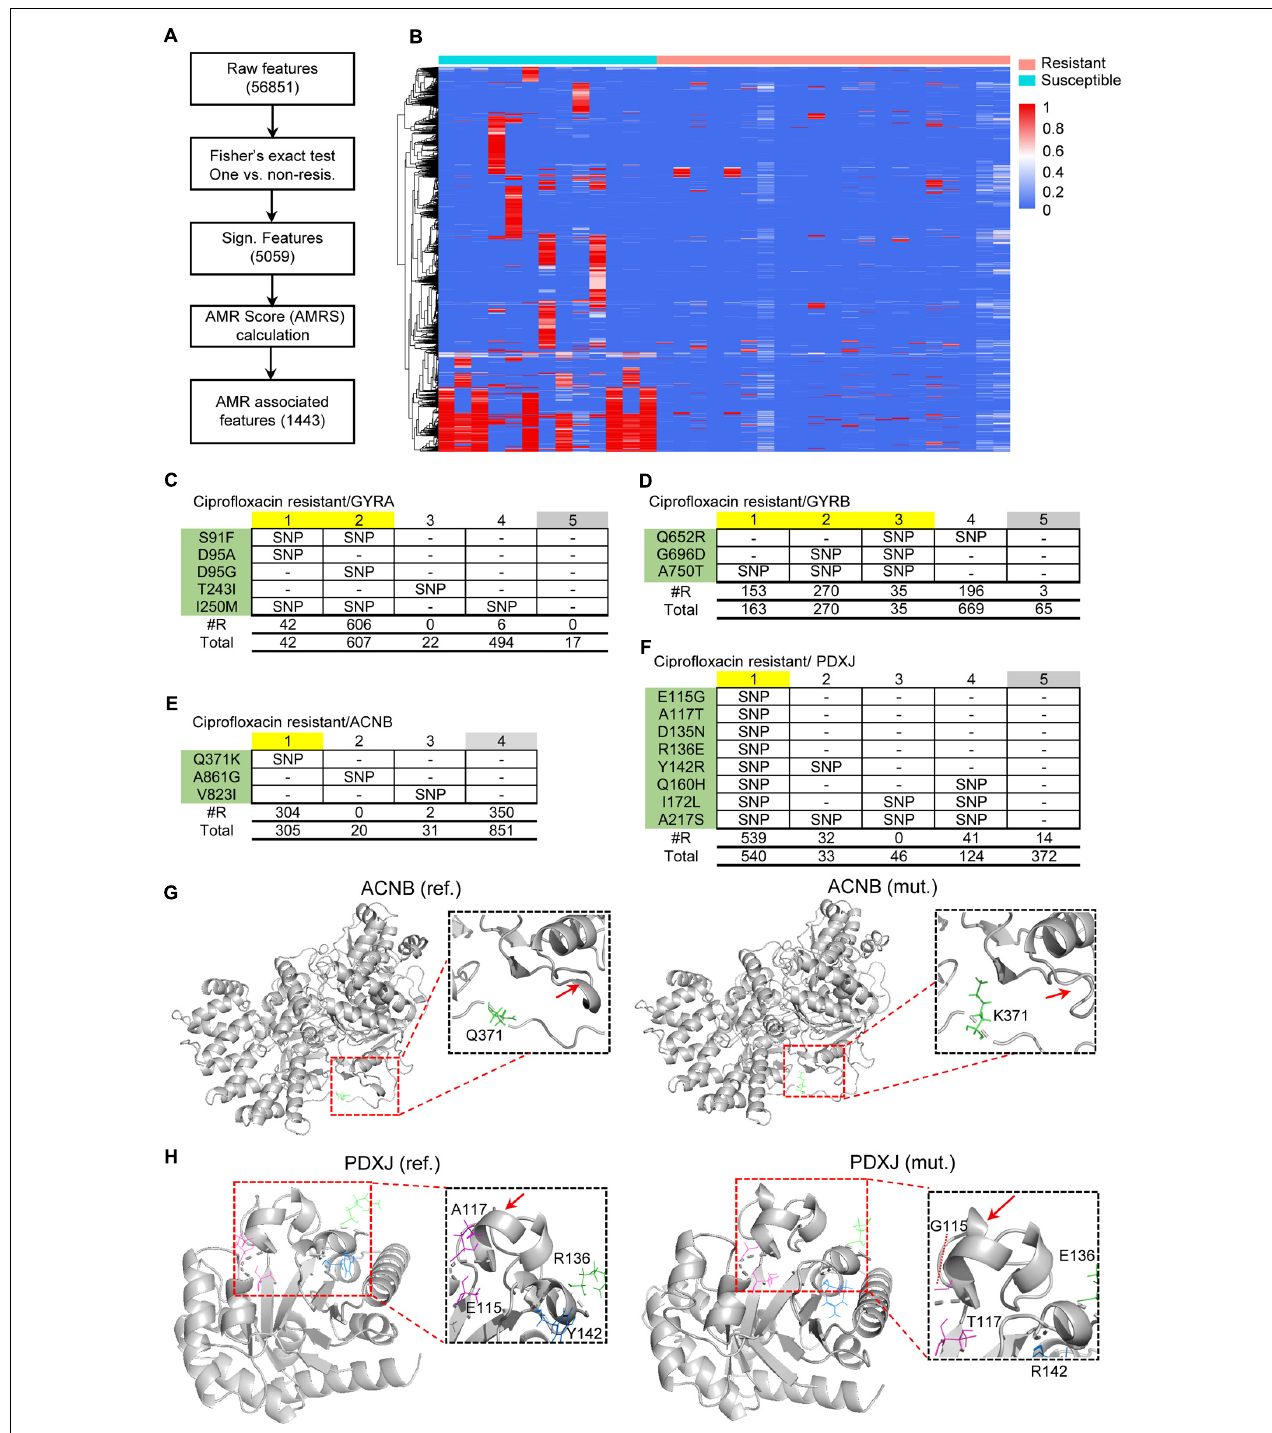
FIGURE 4 | Integrative analysis identified known and novel antimicrobial resistance (AMR), features. (A) Analysis pipeline for extracting AMR-associated features using AMR, score (AMRS). (B) Heatmap showing distinct AMR-associated features in ciprofloxacin-resistant and -susceptible clusters, indicating distinct mechanisms in different clusters with the same phenotype. Mutation tables for (C) GYRA, (D) GYRB, (E) ACNB, and (F) PDXJ, genes associated with ciprofloxacin resistance. Rows represent mutation position, and columns represent gene alleles; gray boxes represent those chosen as the references, and yellow represents those chosen as AMR-associated features. “SNP” indicates that there is an SNP, in the gene allele. The two rows below each mutation table show the number of resistant strains and the total number of strains. Predicted 3D structures of (G) ACNB, and (H) PDXJ, proteins with mutations, indicating that AMR-associated gene alleles may achieve AMR, by altering the structure of the proteins. Red arrows indicate protein structure alterations based on the AMR-associated gene alleles.